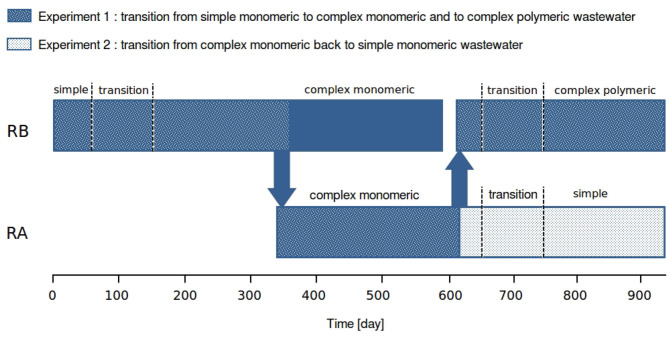
Summarizing diagram of the reactor operation and the two experiments. Experiment 1 started in RB with AGS acclimated to a simple wastewater [containing mainly volatile fatty acids (VFA)]. The wastewater feeding the AGS was progressively replaced by a complex monomeric wastewater (containing VFA, glucose, and amino acids). On day 333, half of the sludge of RB was used to start reactor RA. The two reactors were fed with complex monomeric wastewater. On day 600, RB was stopped and emptied. On day 607, half of the sludge from RA was used to re-start RB. In RB, the complex monomeric wastewater was progressively replaced by a complex polymeric wastewater (containing VFA, glucose, amino acids, starch, and peptone). In RA, the complex monomeric wastewater was progressively replace by a simple wastewater.